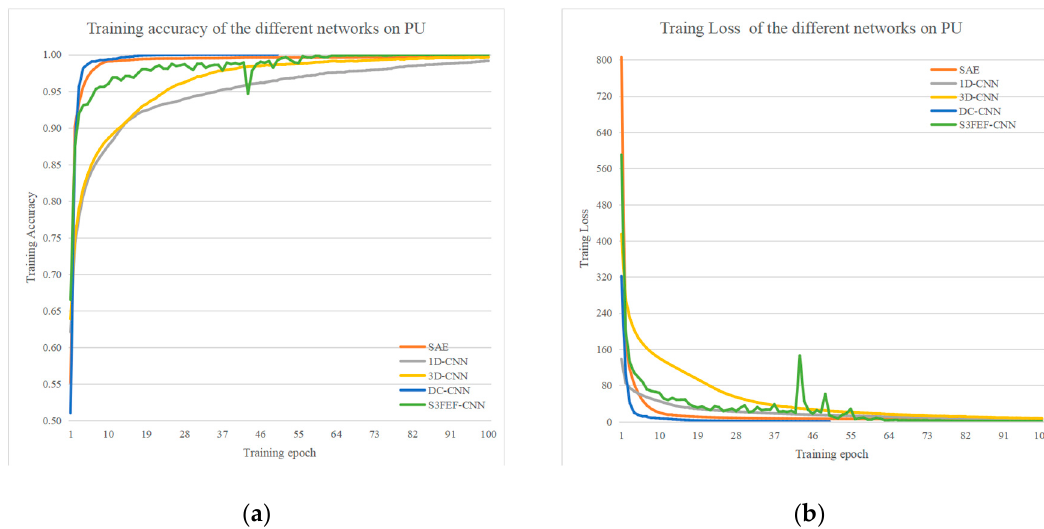
Figure 9. ( a ) Training accuracy curves on the PU dataset of different networks; ( b ) Loss curves on the PU dataset of different networks.